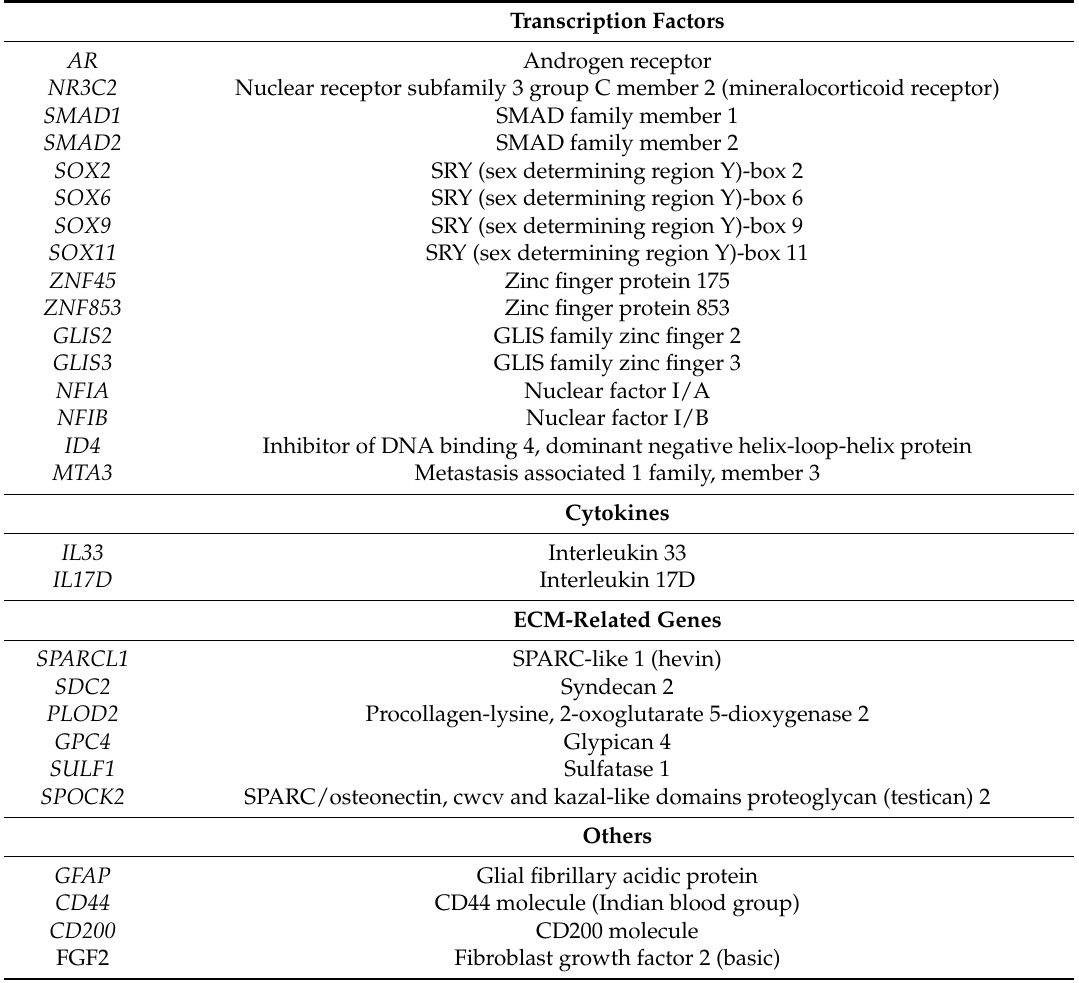
Table 2. List of functionally-relevant genes that co-express with GJA1 / Cx43 in spinal cord periplaque